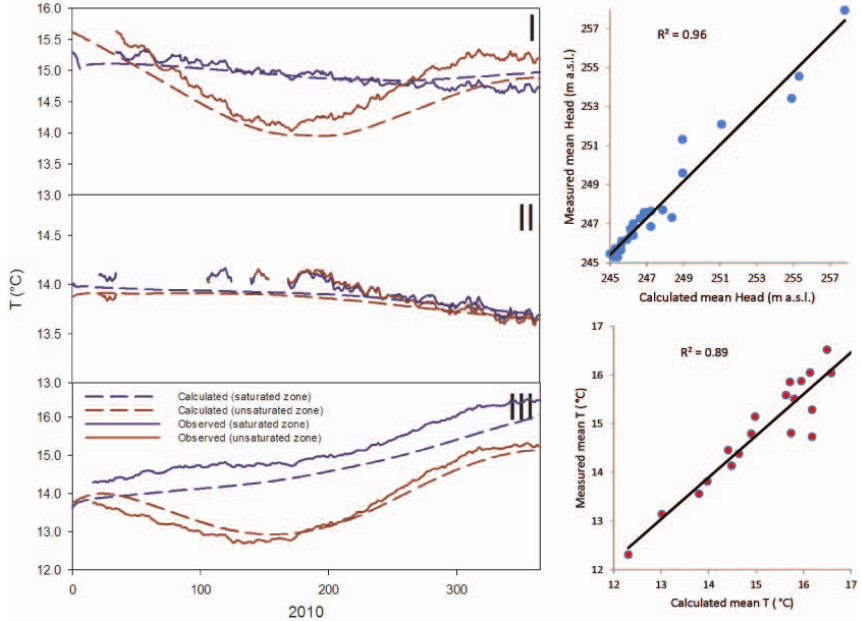
Fig. 6. Left panels: calibration results for the local 2-D and 3-D heat transport models at the locations of multilevel groundwater observation wells I–III (for locations see Fig. 1). Right panels: calibration results for the regional 3-D heat transport